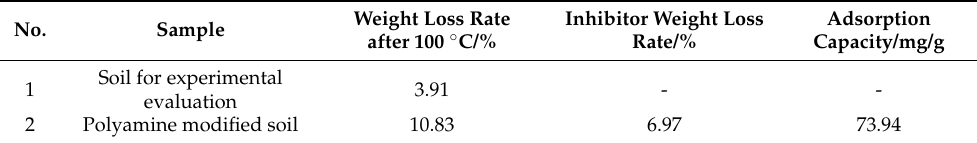
Table 1. Adsorption capacity of polyamine inhibitor on clay.